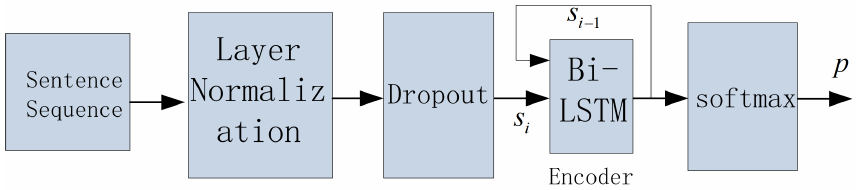
Figure 8. The network architecture of the text classifier.